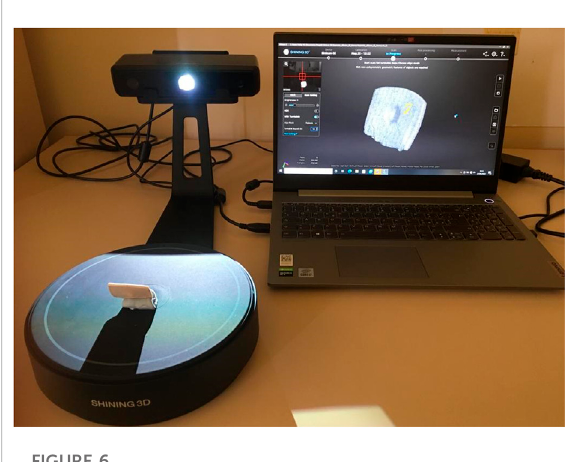
FIGURE 6 3D scanning procedure.